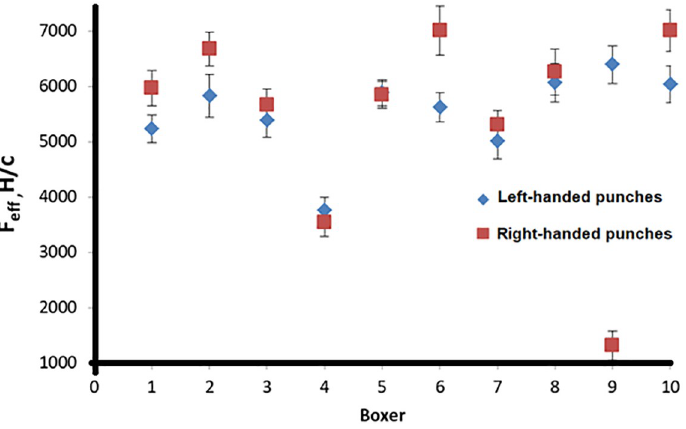
Fig 5. The effectiveness of 10 boxers’ punches made with the left (rhombus) and right (square) hands.